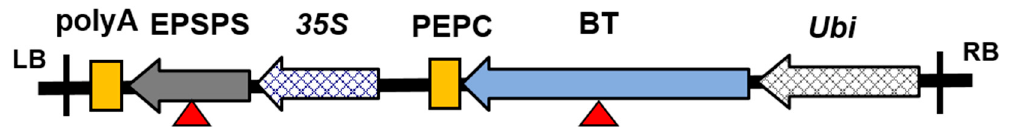
Figure 1. Structure of the plant expression vector containing coding regions of the cry1Ab/cry2Aj-G10evo genes. LB is left border; RB is the right border; poly A is a terminator; PEPC is a terminator; 35S is a promoter; Ubi is a promoter; EPSPS denotes the herbicide-resistant genes; BT denotes the insect-resistant genes; EPSPS and BT are marked with a red triangle.